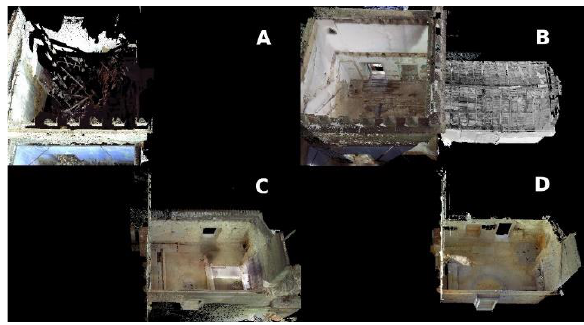
Figure 16. Continuous update of the laser scanning survey. A: